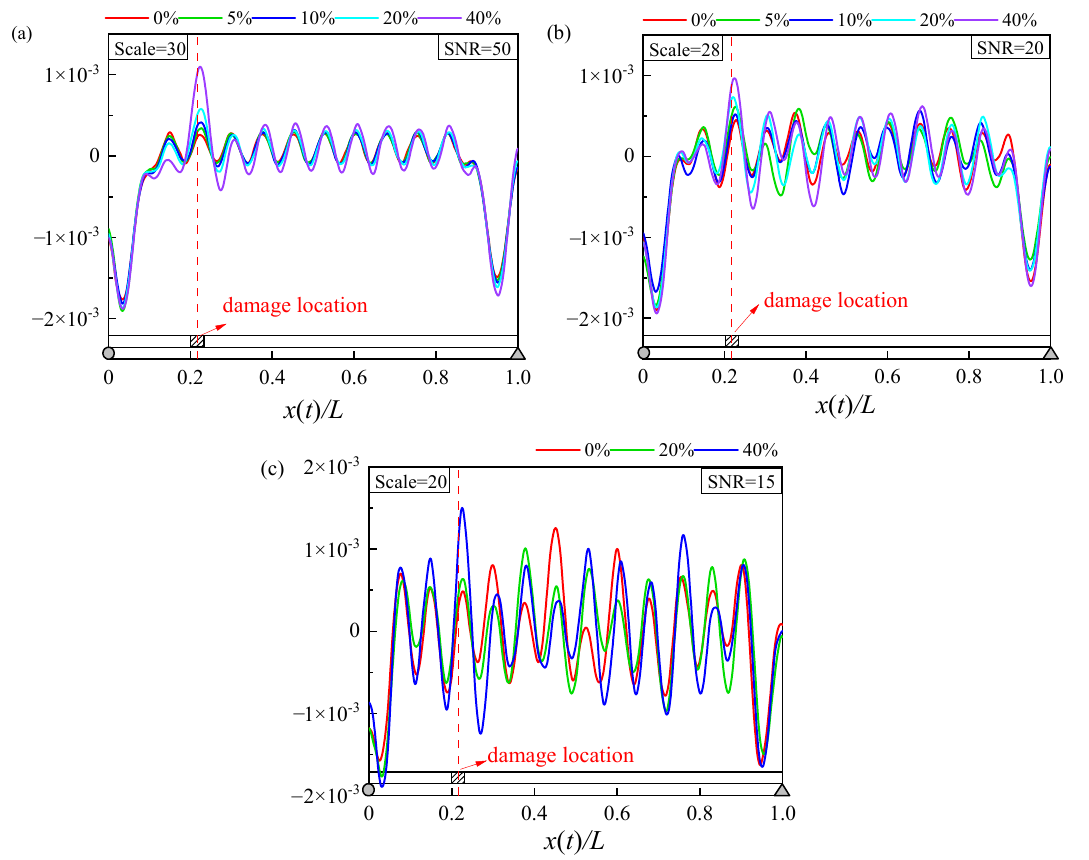
Figure 12. CWC extracted from signals with noise with different SNRs: ( a ) SNR = 50; ( b ) SNR = 20; ( c ) SNR = 15.